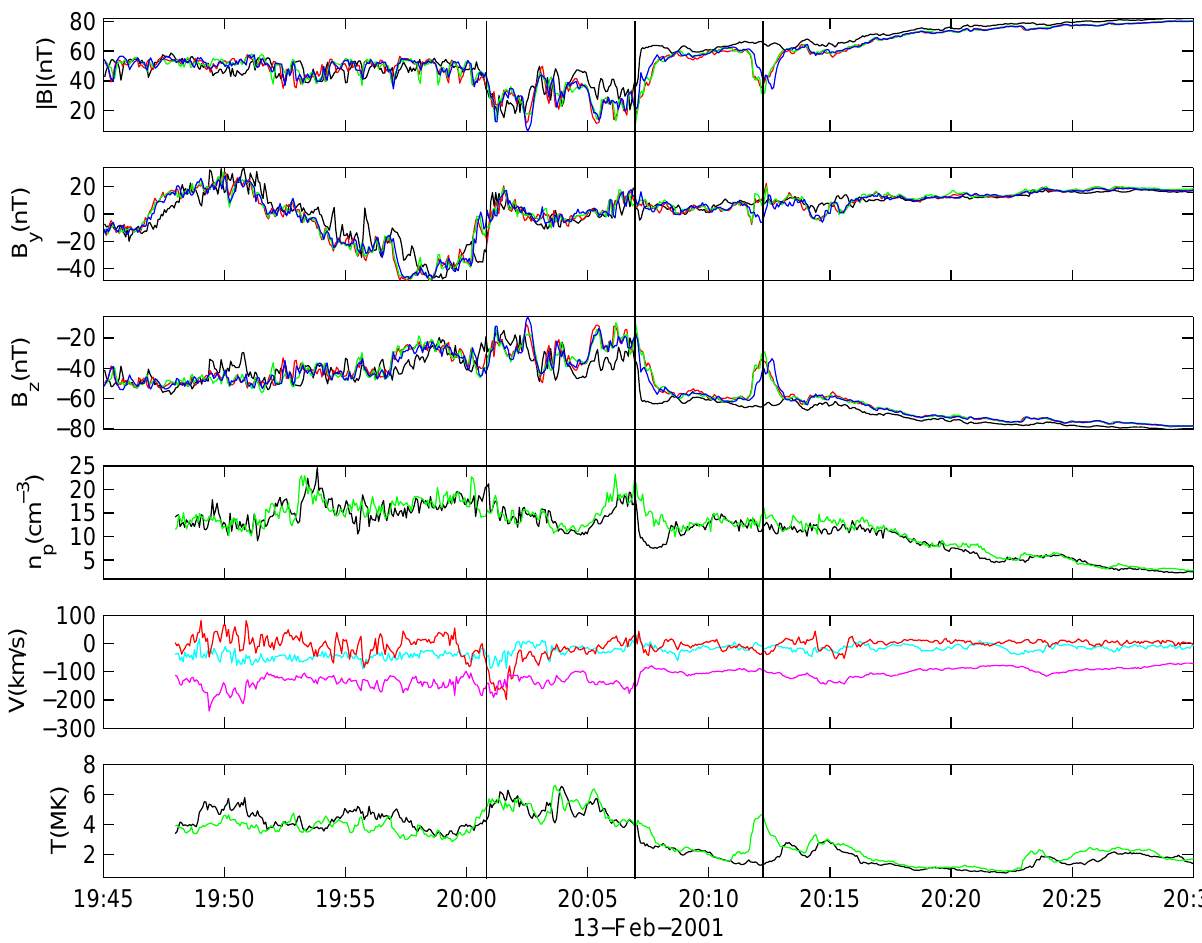
Fig. 4. An overview of the magnetic field and plasma parameters between 19:45 and 20:30UT on 13 February 2001. The six panels show | B | , B y B z , n, V and T. The x, y and z components of the plasma velocity seen by spacecraft 3 are denoted by cyan, red and magenta lines in panel 5. The three vertical lines refer to features discussed in the text. There is a data gap in the plasma data before